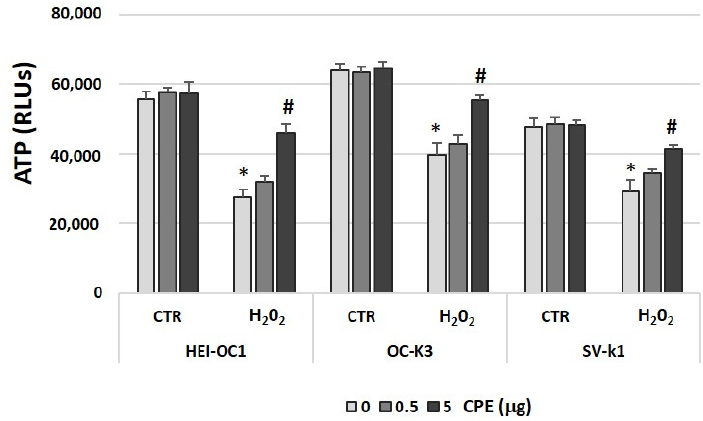
Figure 10. Cocoa increased ATP levels in senescence auditory cells. ATP levels were measured by a luminescence assay in cell lysates of HEI-OC1, OC-k3, and SV-k1 cells post-treatments. Experimental groups: CTR group (0; 0.5 and 5 µ g/mL of CPE) and H 2 O 2 group (induced cellular senescence with 100 µ M for 1 h in all groups: 0; 0.5 and 5 µ g/mL of CPE). The values represent the mean ± SD Relative Luminescence Units (RLU) in triplicate. * p < 0.05 vs. CTR group; # p < 0.05 vs. H 2 O 2 group ( n = 4).